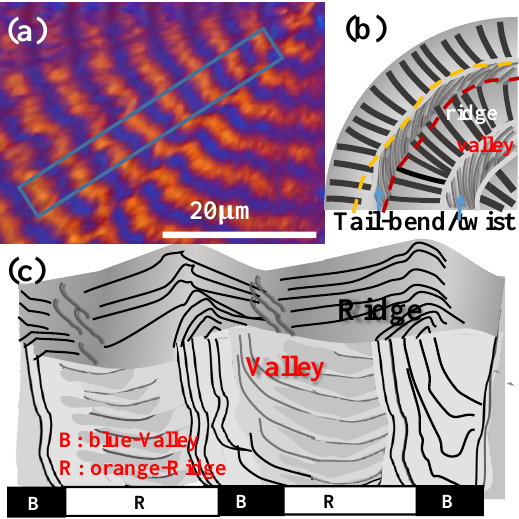
Figure 10. ( a ) POM graph with alternate birefringence bands, ( b ) schematic for top-surface mor- phology, and ( c ) schematic of correlation between optical bands and interior lamellae of banded PBA crystallized from PBA/PEO (90/10) at 30 °C. R-red tint color, B = blue tint color. Blue-block indicating the radial direction of alternate birefringence changes.